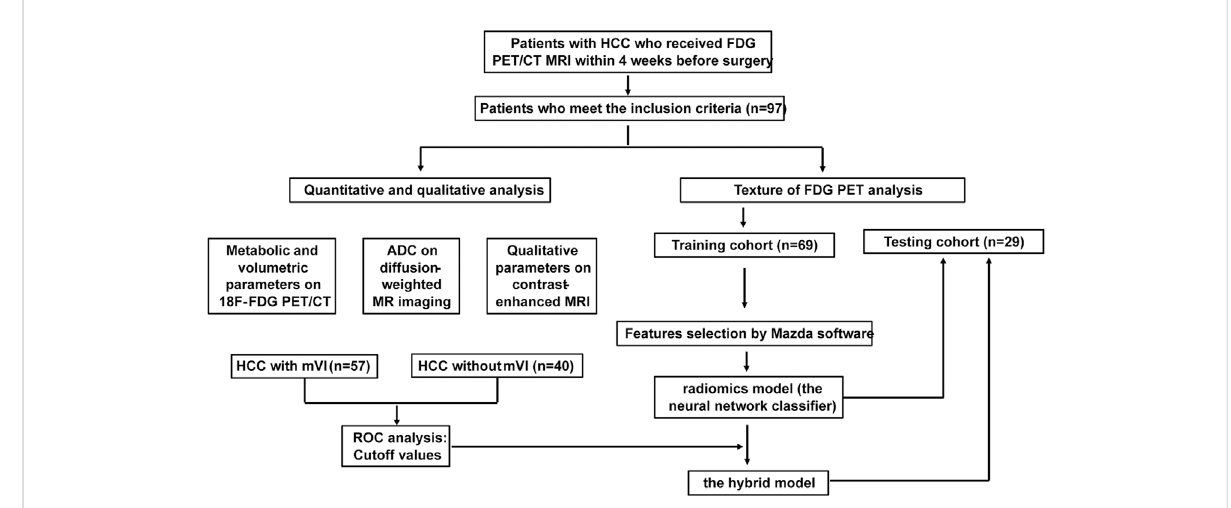
FIGURE 4 Study fl owchartforpredictingmVIbyanalyzingPETtexturefeaturesandthehybridmodelincorporated 18 FFDGPET/CTandMRIintrainingand testing